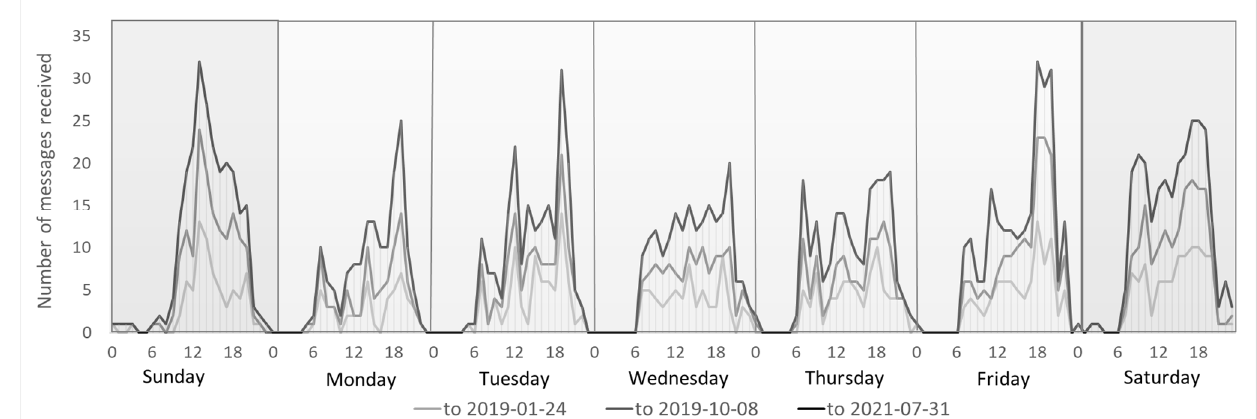
Figure 8. Frequency distribution of incoming messages by hour of day and day of week shows peak activity on Friday and Saturday evenings and Sunday afternoons. Patterns are consistent over separate cumulative time periods.